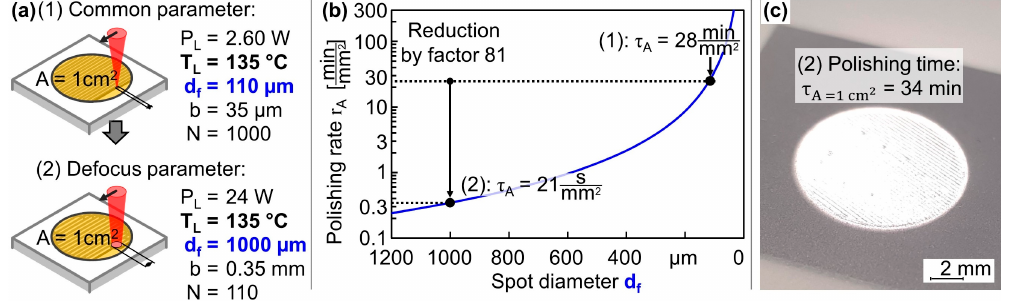
Figure 16. Demonstration of process scalability: ( a ) By using a defocused beam of same thermal load but larger spot diameter; ( b ) the polishing time is reduced significantly; so that ( c ) macroscopic-scaled surfaces can be polished.